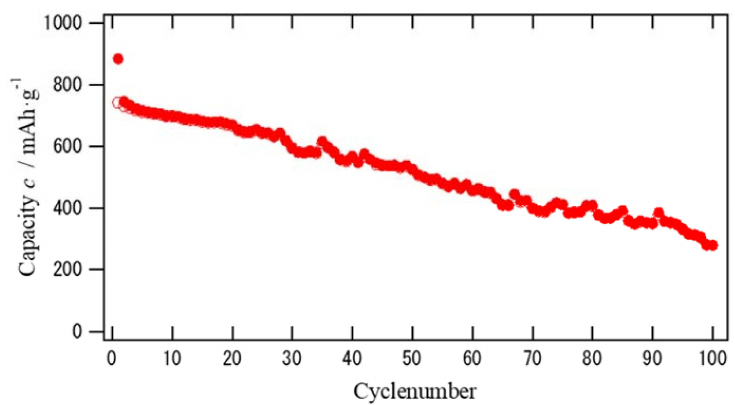
Figure 6. Cyclic performances of the Si/G/CP electrode with 24 wt % and 1.0 µ m Si at 100 mA g − 1 and 25 ◦ C.